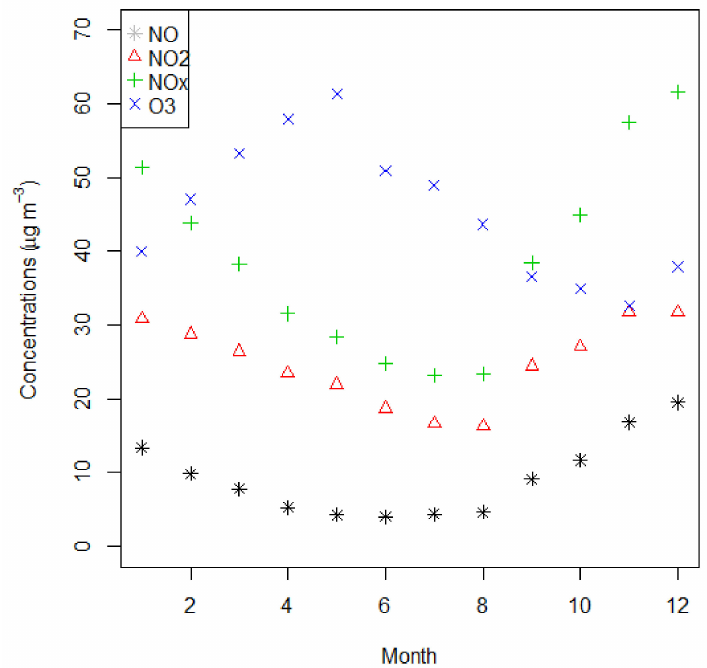
Figure 3. Monthly average concentrations ( µ g/m 3 ) of NO, NO 2 , NOx and O 3 in different months of the year from the Devonshire Green AQMS in Sheffield,